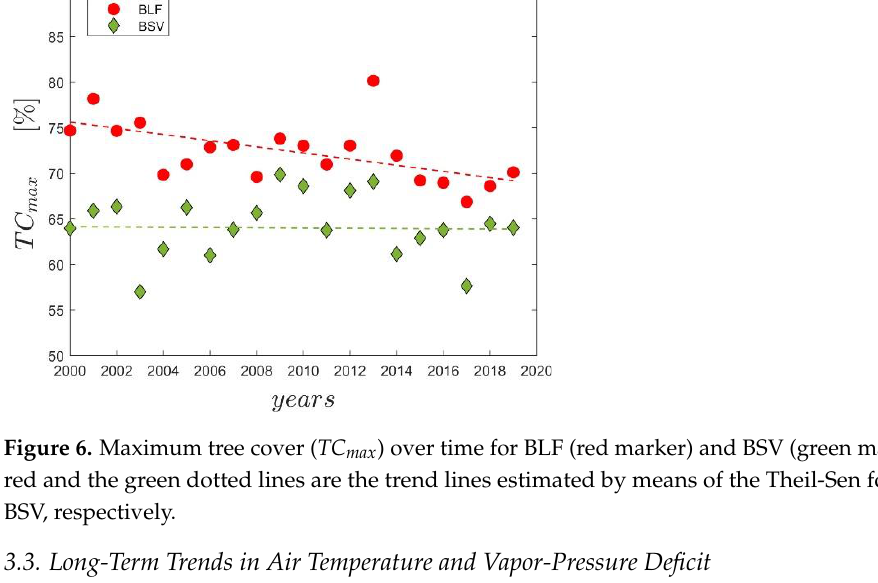
Figure 5. Scatterplot of MODIS MOD44B tree-canopy coverage (TC) as a function of MAP 1922 ‒ 2019 (mm) for broad-leaved forests ( left ) and for bushy sclerophyllous vegetation ( right ) for the year 2008. Maximum tree cover is represented by using a 99th quantile piecewise linear regression (black dotted line). The blue dot in each panel is the change point (identified by the regression analysis, MAP cp ) at which the maximum tree cover ( TC max ) is attained.